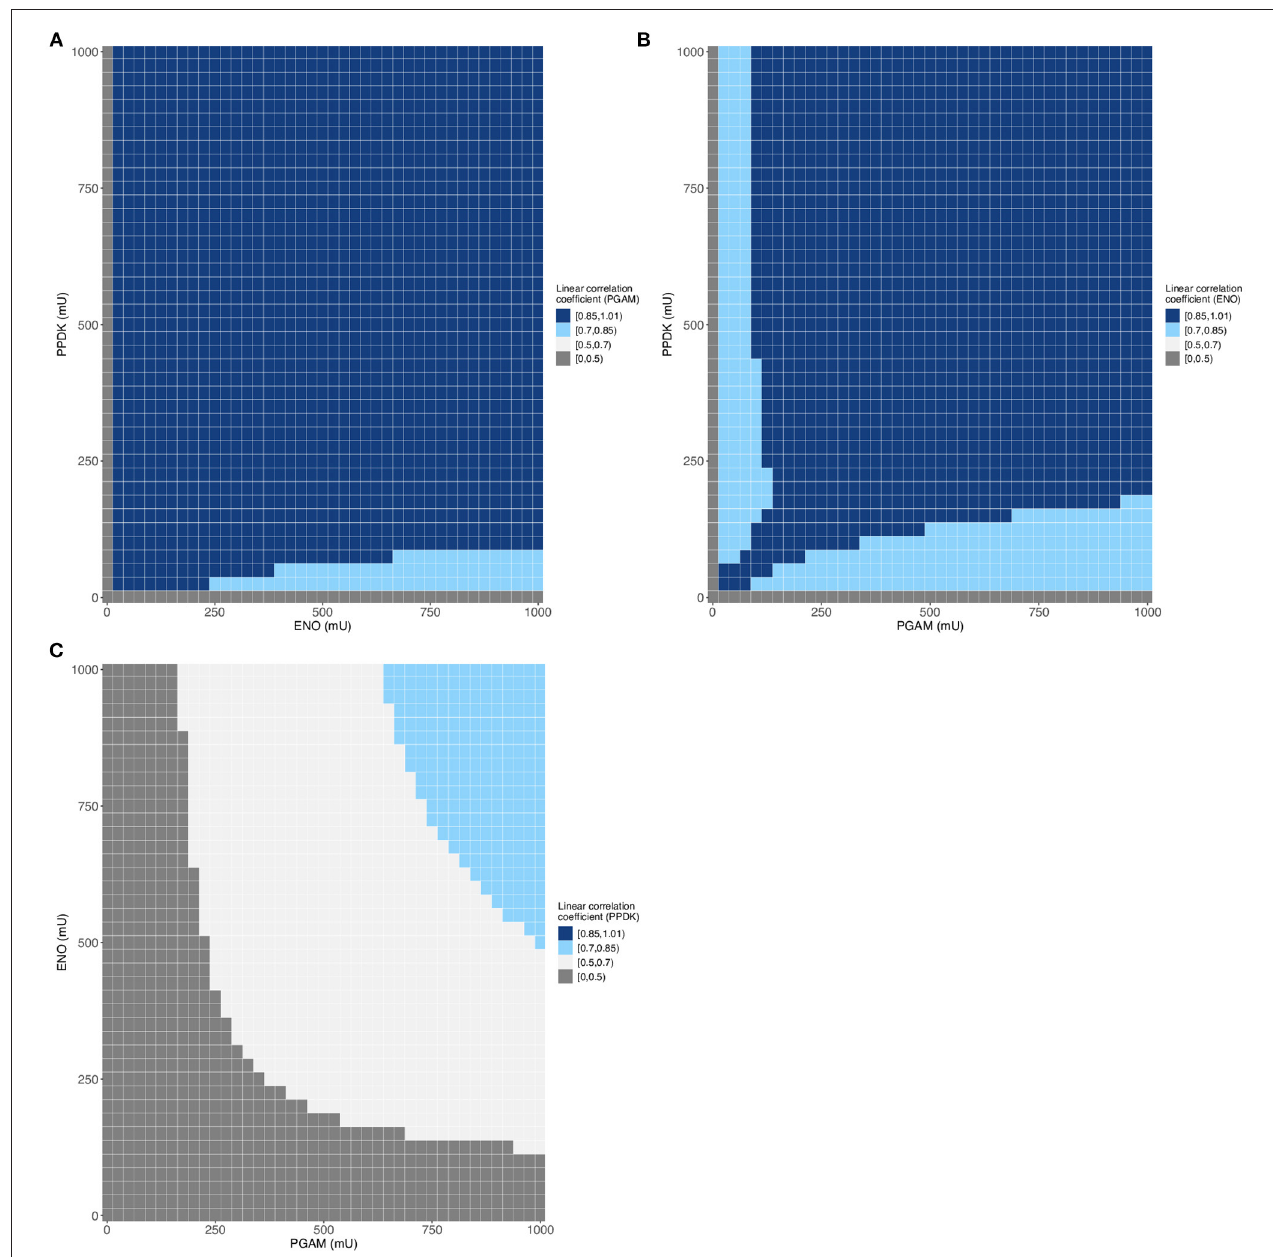
FIGURE 4 | Evolution of linear correlation coefficient for each enzyme of Dataset 1 (68,950 data). (A–C) Variation of PGAM (A) , ENO (B) or PPDK (C) correlation coefficient between enzymes activities and the predicted final flux. the Rborist model: cvRMSE = 0.647 nmol · min − 1 and cvR 2 =